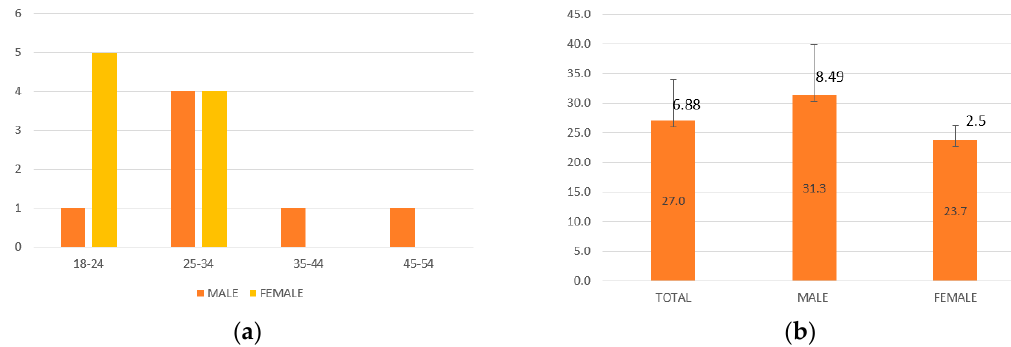
Figure 9. ( a ) Ages of the 16 users; ( b ) mean value and standard deviation of age and gender of the 16 users.